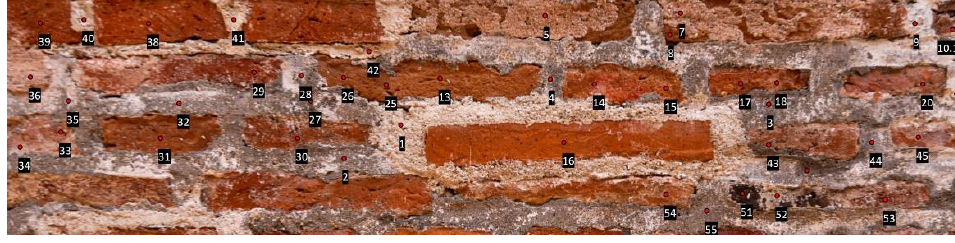
Figure 4. LIBS analysis spots.